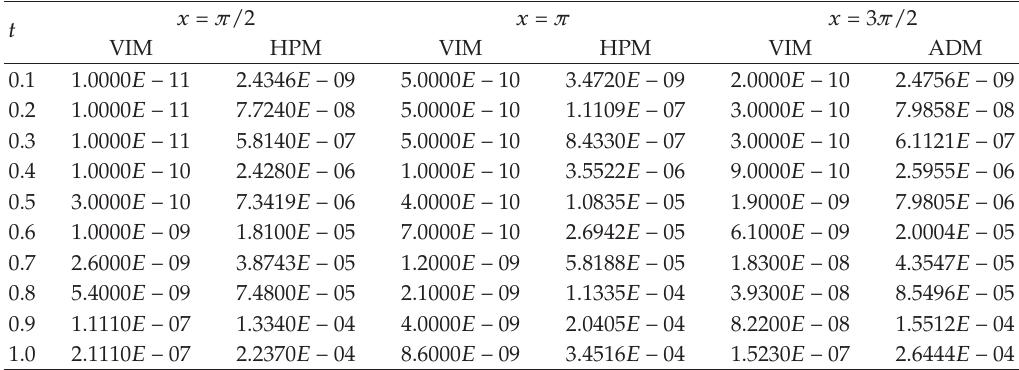
Table 4: Errors of the approximate solution of fractional Rosenau-Hynam equation using fifth term of HPM and fifth iterate of VIM when α (cid:8) 1 . 0 and c (cid:8) 0 .